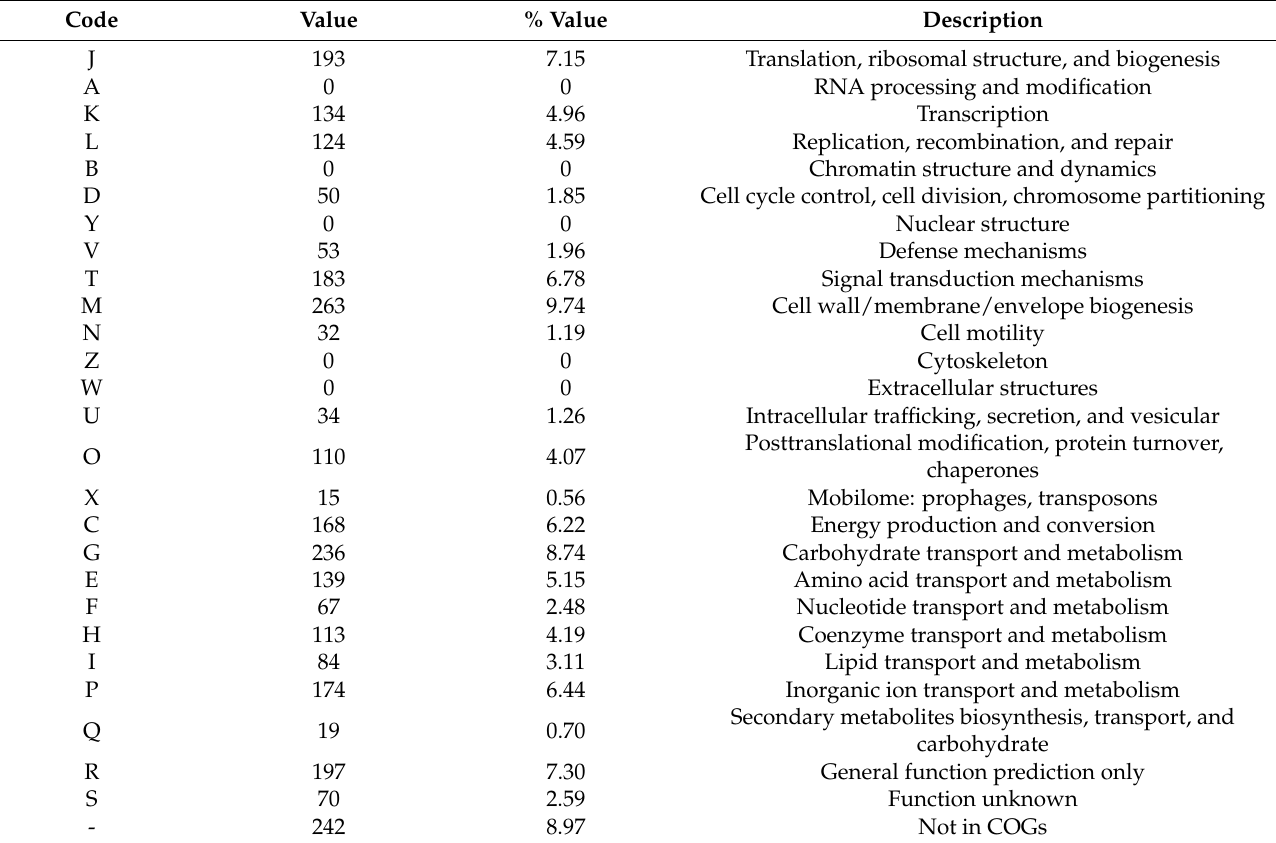
Table 3. Number of genes associated with the 25 general cluster of orthologous group (COG) functional